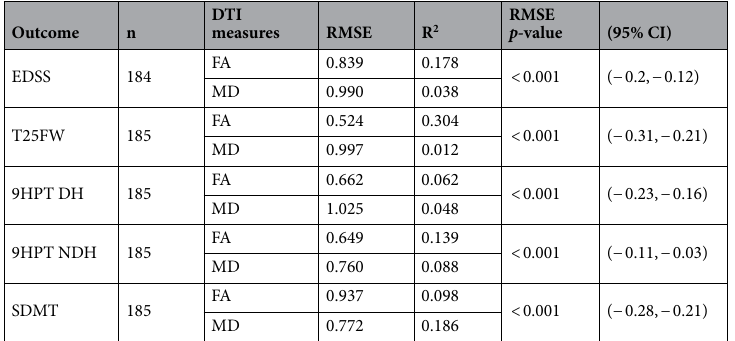
Table 3. Performance evaluation of fractional anisotropy and mean diffusivity values predicting each outcome at follow-up. Results are shown as the Root Mean Square Error (RMSE) and R 2 value of Lasso models. Lasso regressions analysis performance. The p -values were obtained after comparing the RMSE of the two models for each outcome using a paired sample t-test. The 95% confidence interval refers to the differences in RMSE between the two models. DTI diffusion tensor image; RMSE Root Mean Squared Error; R 2 R-squared; CI confidence interval; FA fractional anisotropy of white matter atlas; MD median diffusivity from grey matter regions; EDSS Expanded Disability Status Scale; T25FW Timed 25-Foot Walk; 9HPT 9 Hole Peg Test; DH dominant hand; NDH non-dominant hand; SDMT Symbol Digit Modalities Test. One patient was excluded due to an unavailable EDSS